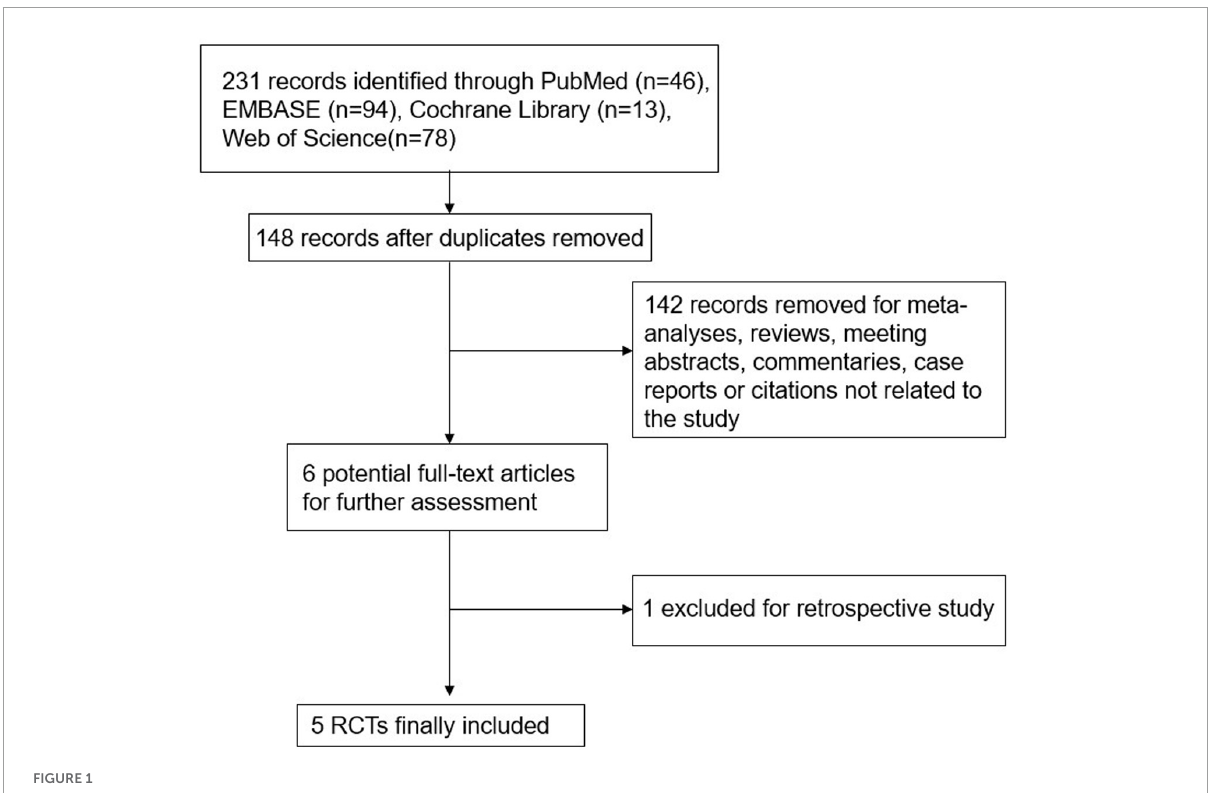
FIGURE1 Flow chart of study